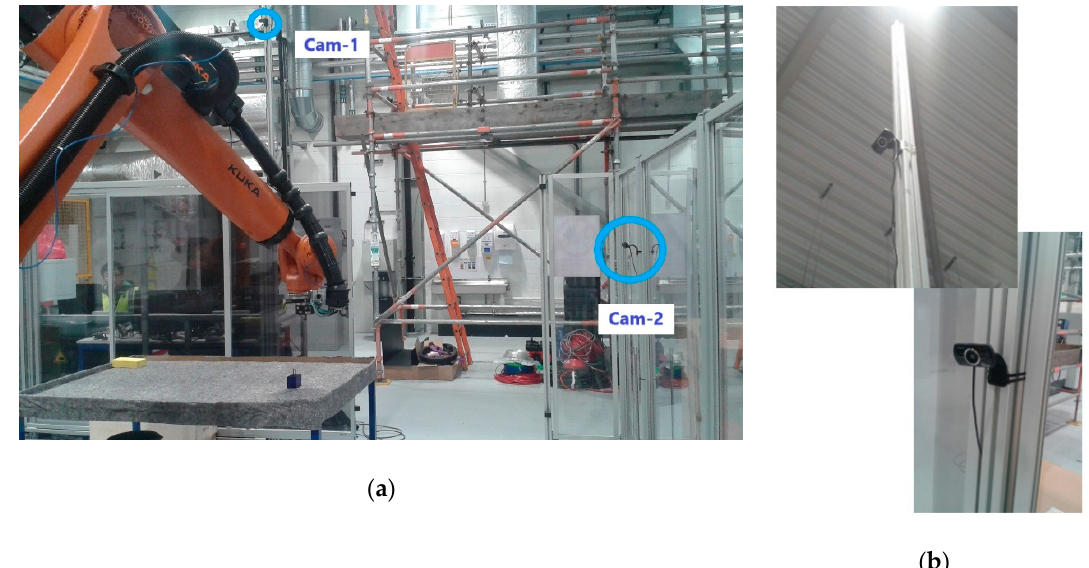
Figure 13. Disposition of the cameras for experiments: ( a ) Relative location of cameras with relation to the robot workspace; ( b ) Close-up view of cameras attached to cell caging.